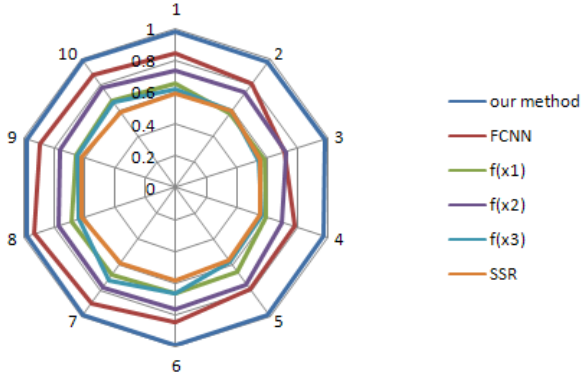
Figure 7. Packet transmission success ratio with varying RSS by adding log normal random fading with N (0, σ 3